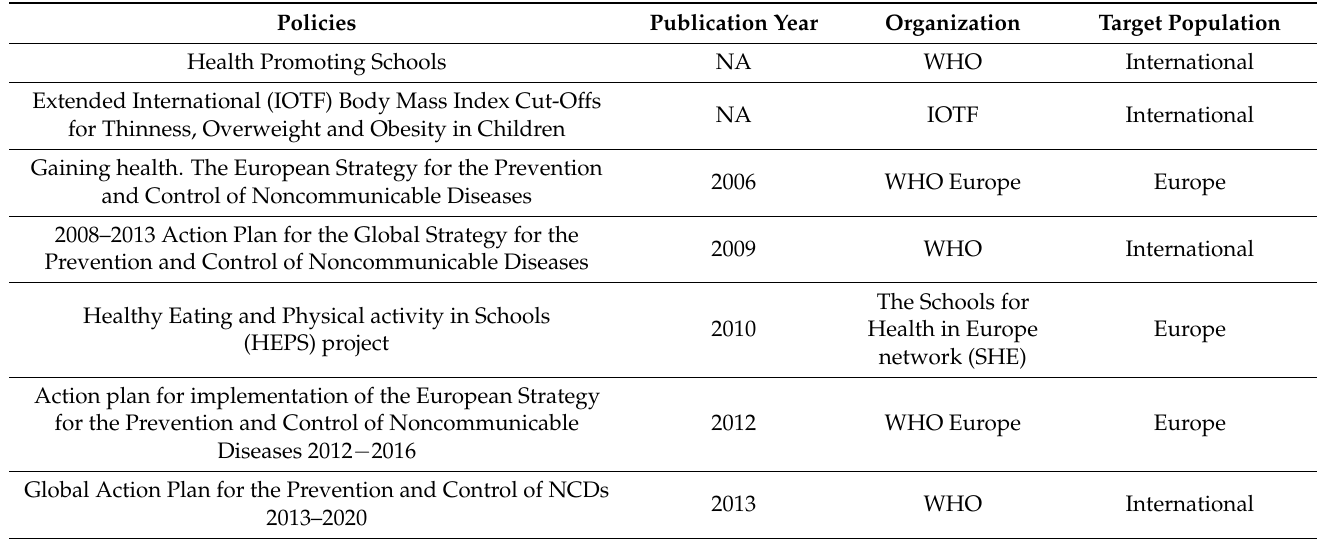
Table 3. Documents with reference to childhood overweight and